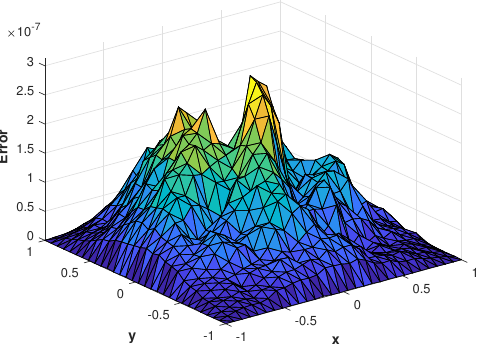
= 900, N S = 18, σ n = 20 at T = 1 correspond- Figure 13. Rms Error of the proposed method with Figure 13: Rms Error of the proposed method with = 900 , N S = 18 , σ n = 20 at T = 1 corresponding to G N G N problem 3. ing to problem